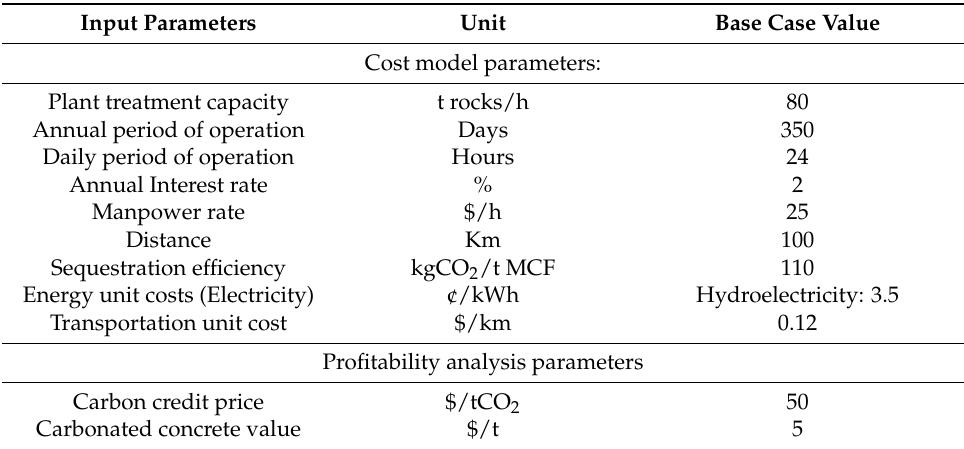
Table 4. MCF carbonation economic analysis base case scenario input parameter.